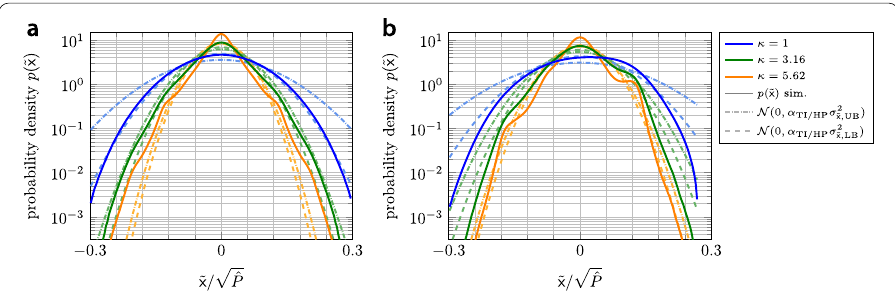
t k ,TI and b t k t k ,HP (solid lines) and bounds on x ( t k ) for a t k ˜ = = x ( t k ) is suitable for κ ≲ ˜